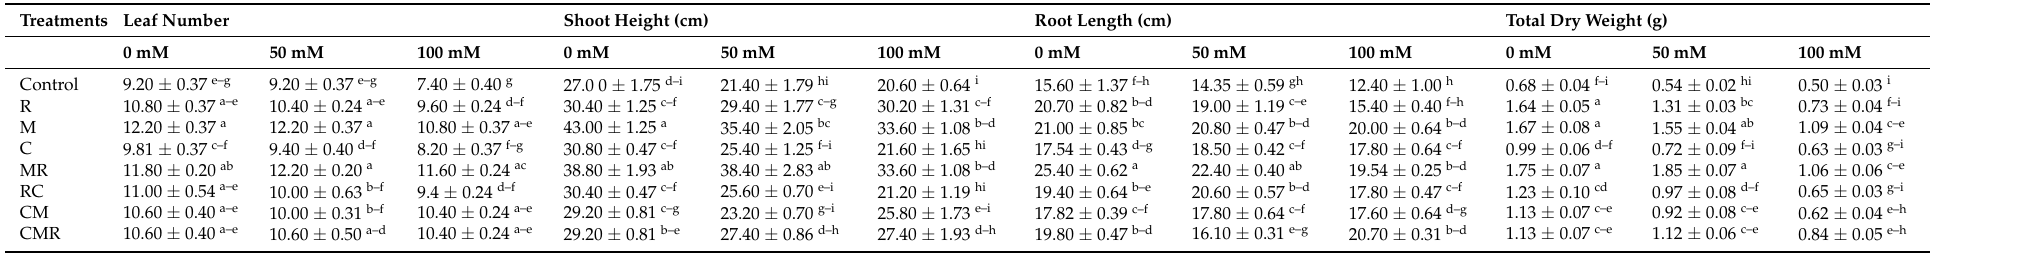
Data are mean ± SE of five biological replicates. Means followed by the same letters are not significantly different at p < 0.05 (Tukey’s